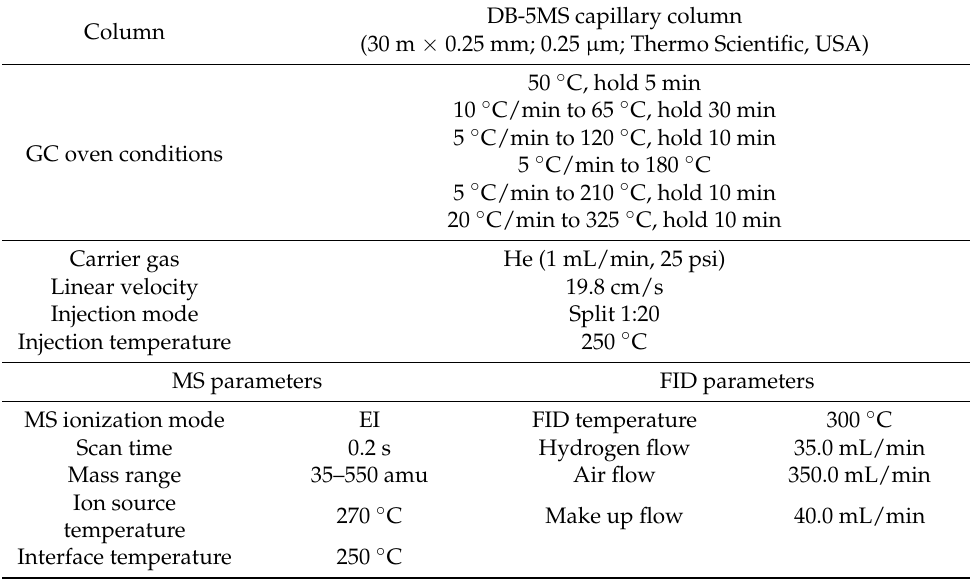
Table 2. Operating parameters of